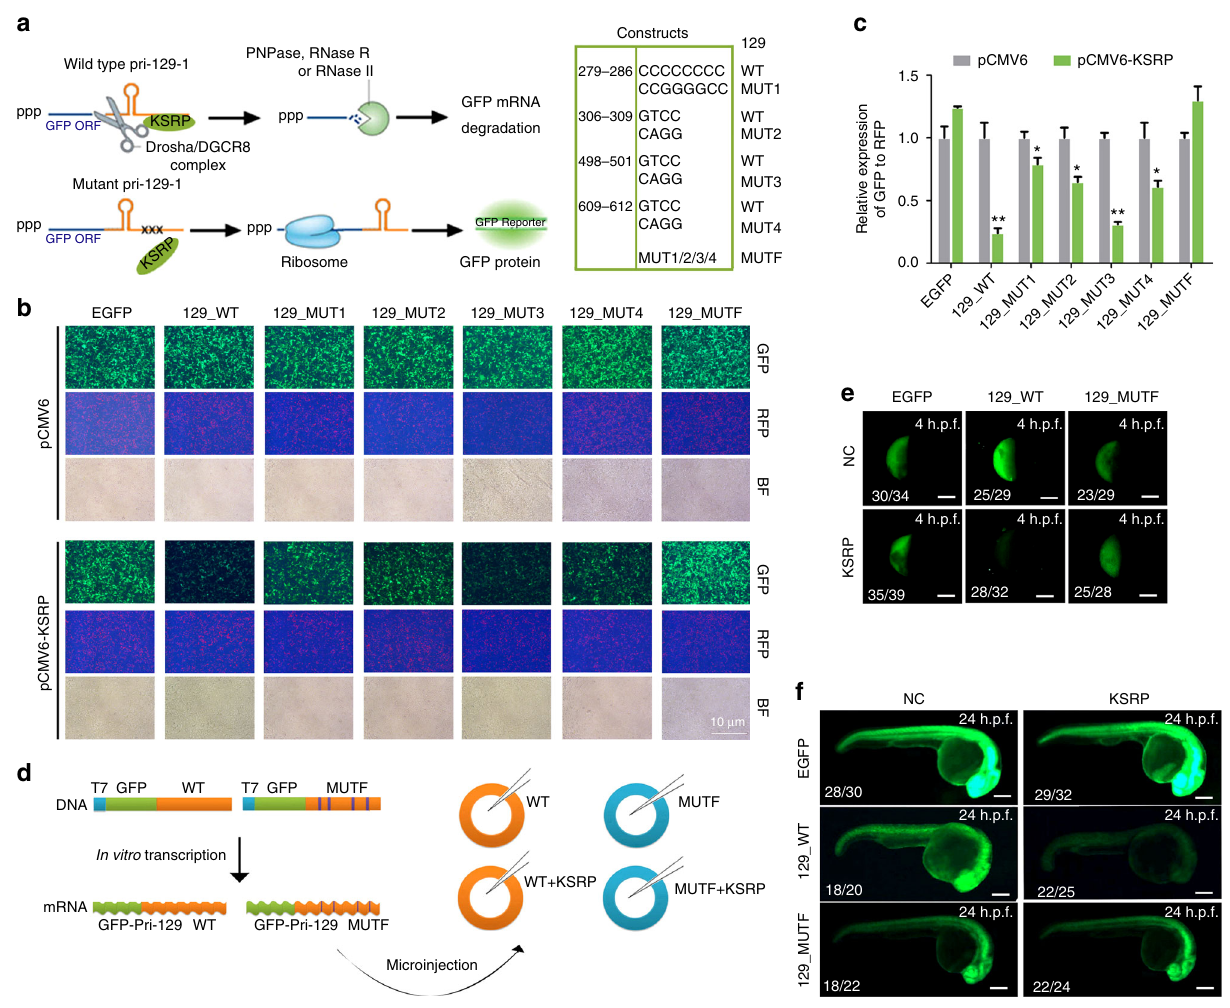
Fig. 7 KSRP promotes the processing of pri-129-1 in vivo. a Schematic representation of the in vivo processing assay performed by co-transfecting GFP- labeled pri-129-1 (129_WT) or GFP-labeled KSRP-binding site mutant (129_Mut1, 2, 3, 4 for each site and 129_MutF for all four sites) constructs with the KSRP construct or empty vector. The mutant sequences in the constructs are shown in the right panel. b Images of GFP and RFP fl uorescence in 293 T cells used in the in vivo processing assay, as indicated in h (Scale bar, 100 μ m). RFP fl uorescence from a co-transfected plasmid was used as control for transfection ef fi ciency. c The quantitative ratio of GFP expression to RFP expression in b . d Schematic representation of the in vivo processing assay in zebra fi sh, as described in the Methods. e , f Images of GFP fl uorescence in the 4 h.p.f. e or 24 h.p.f. f zebra fi sh embryos at after the zebra fi sh zygote was microinjected with a combination of GFP-pri-129_WT or GFP-pri-129_MutF fusion mRNAs with the KSRP mRNA or the control (Scale bar, 200 μ m). Data are shown as means ± s.d. * P < 0.05, ** P < 0.01, Student ’ s t